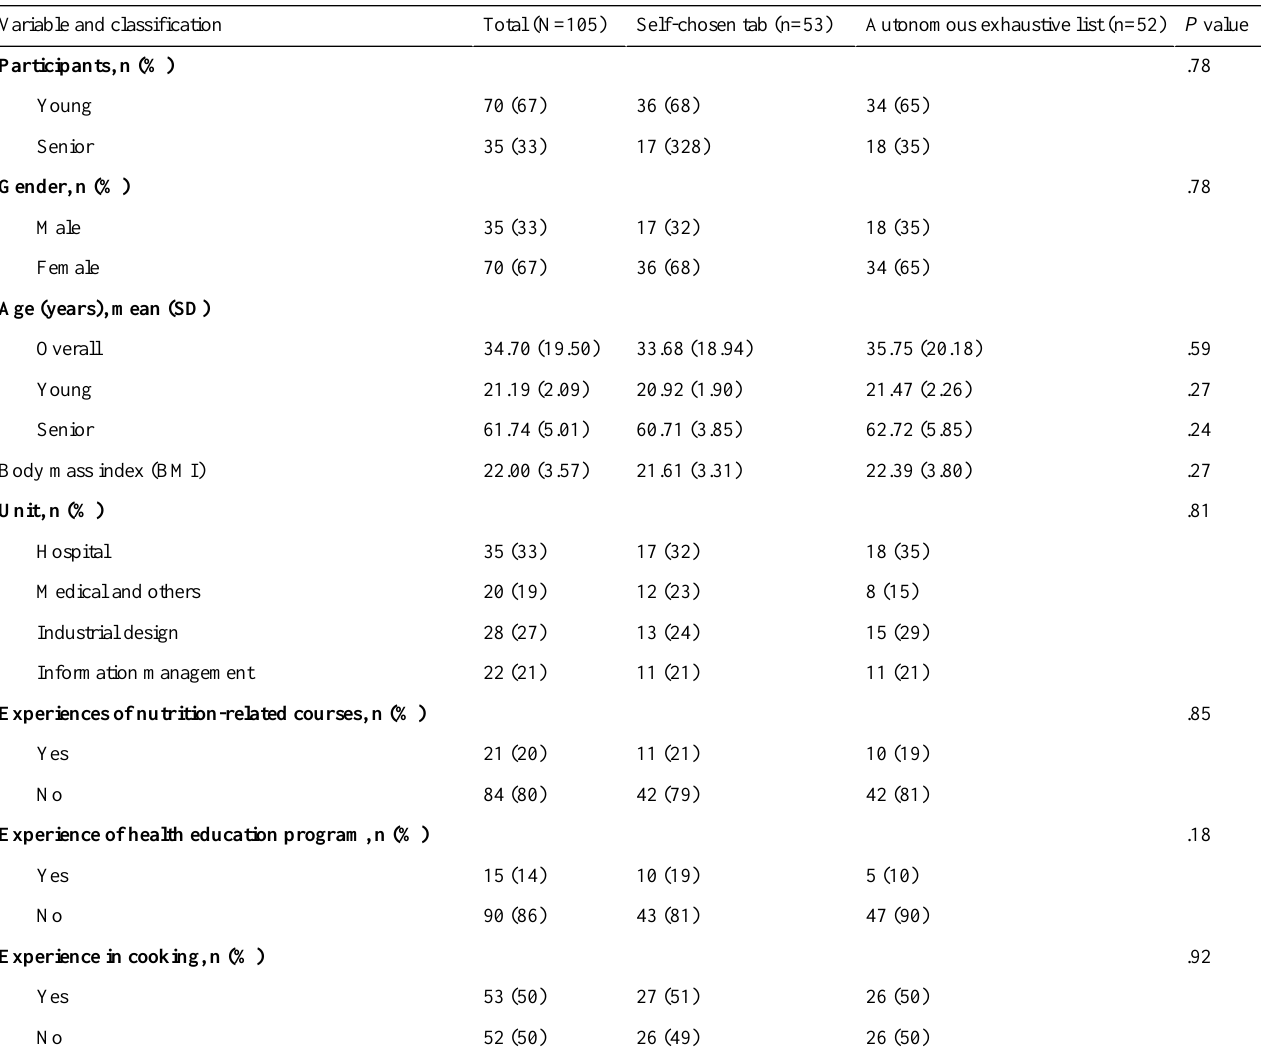
Table 1. Distribution of characteristics among the self-chosen tab and autonomous exhaustive list